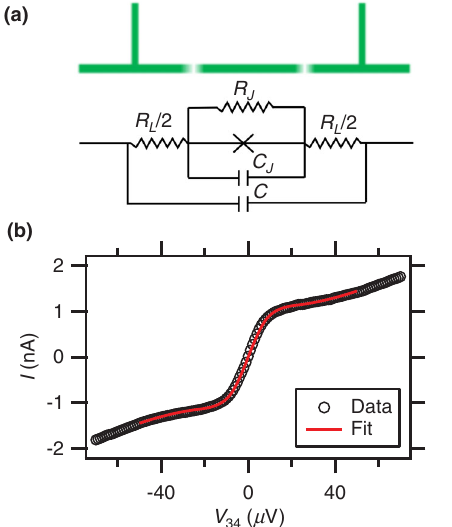
FIG. 7. RCSJ model fitting. (a) Schematic. (b) RCSJ fitting of 0 mV yielding I I - V curve at V sg ¼ 5 . 0 k Ω and R L ¼